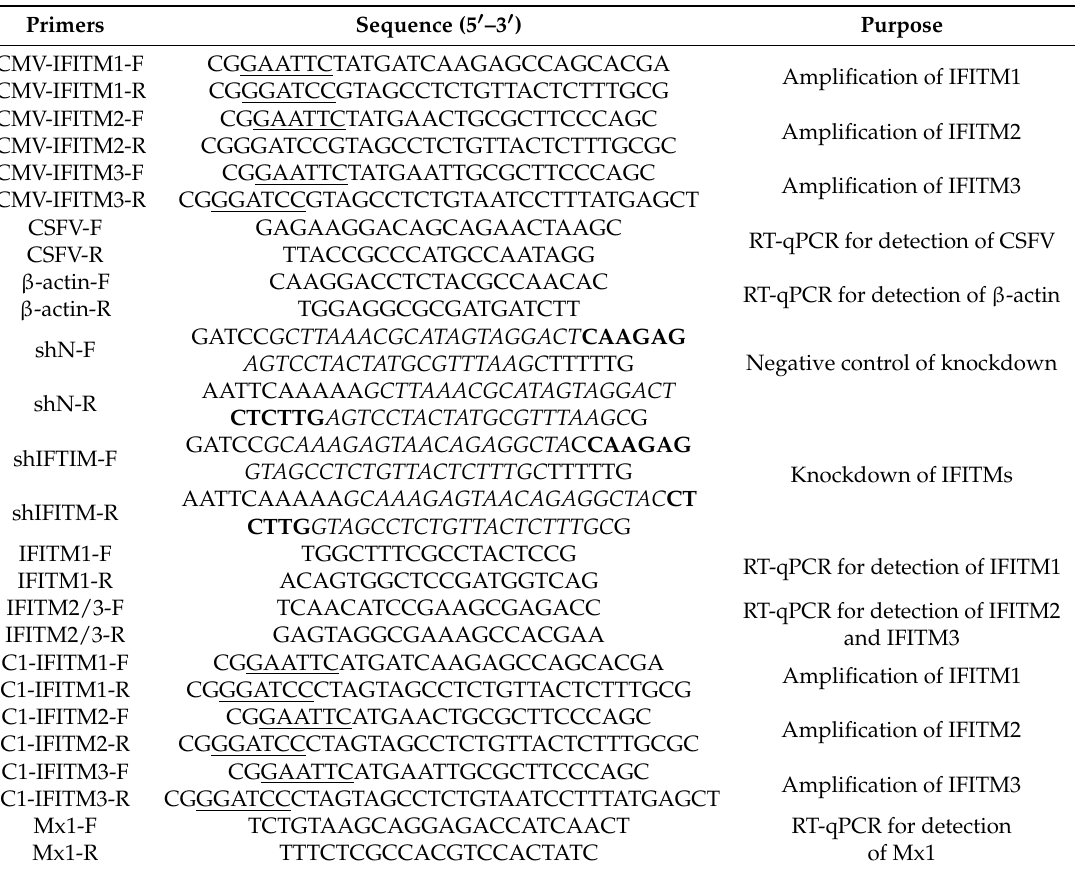
Table 1. Primers used in this